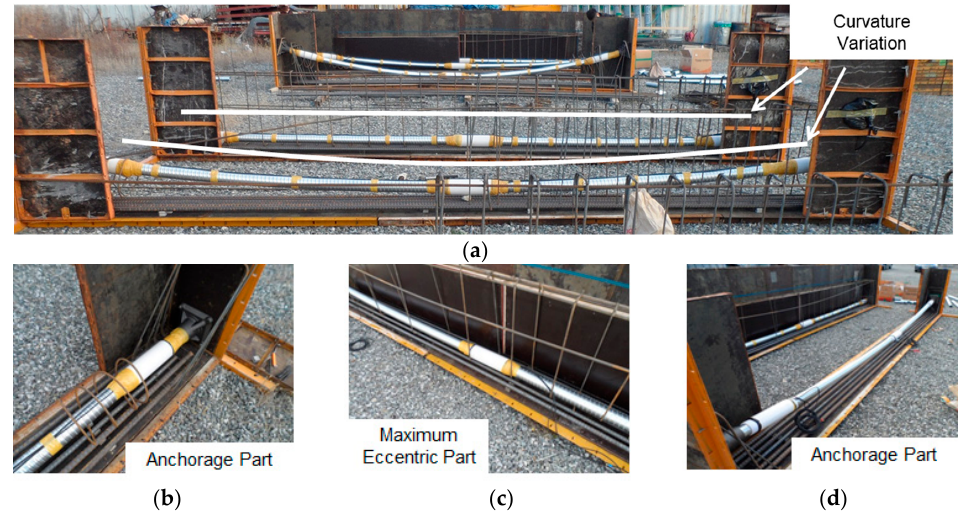
Figure 5. Installation of embedded EM sensors in a PSC girder. ( a ) EM sensor installed PSC girder, ( b ) Right anchorage part, ( c ) Maximum eccentric part, ( d ) Left anchorage part.